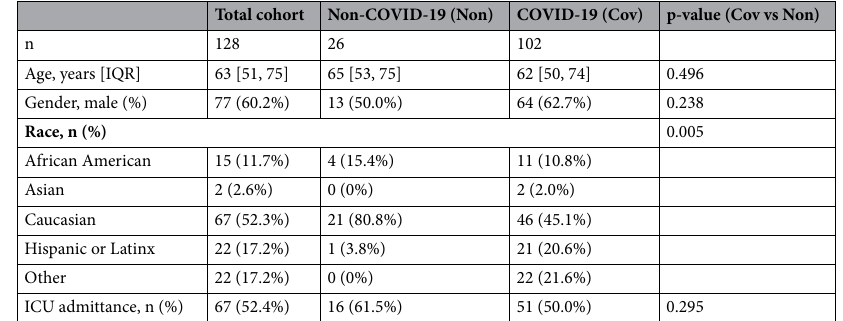
Table 2. External validation (GSE174181) demographics. p-values were calculated using Mann–Whitney U Test and